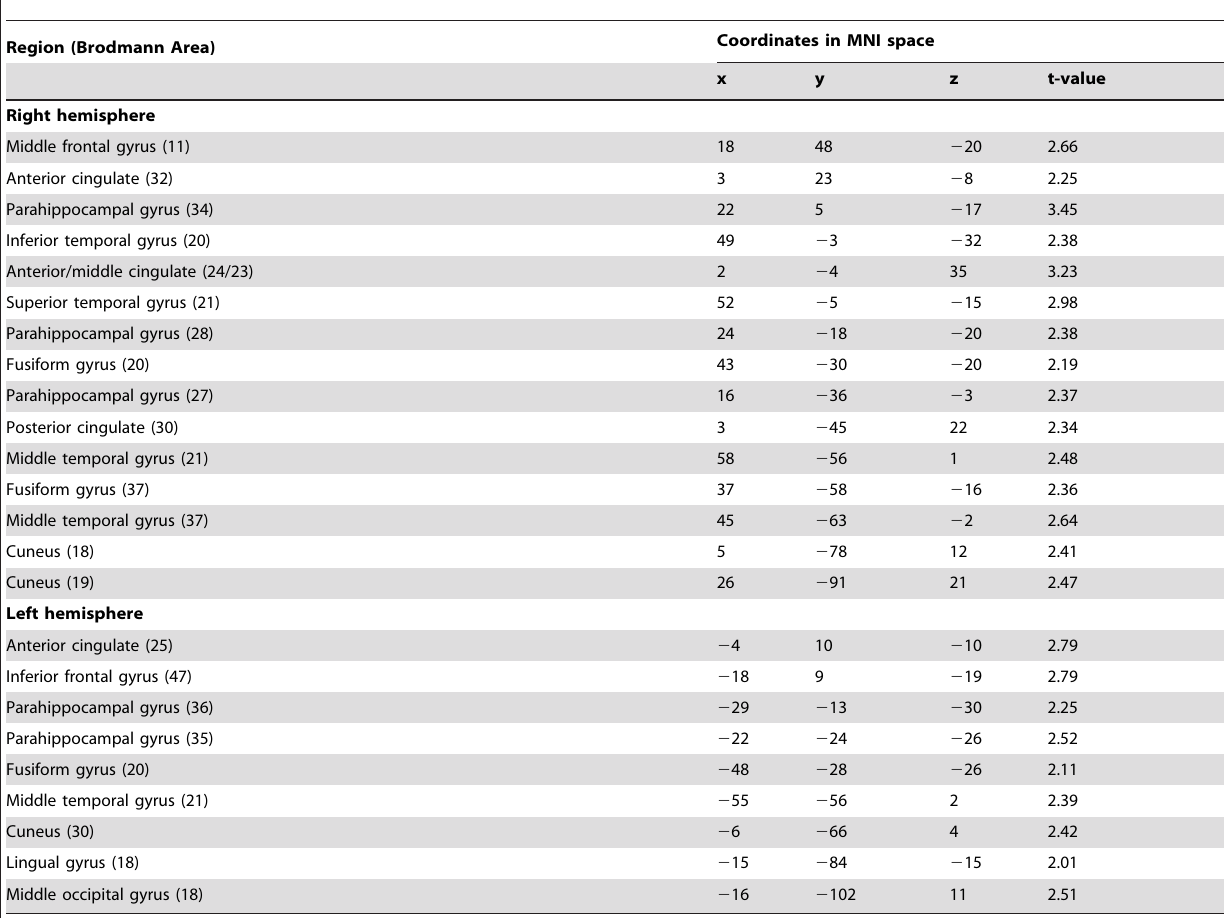
Table 4. Areas of cortical thinning in PNS patients compared to